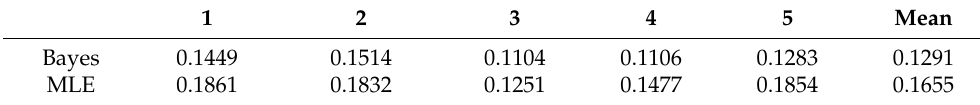
Table 1. MSE of the proposed Bayesian Hierarchical Model and of the likelihood-based one.